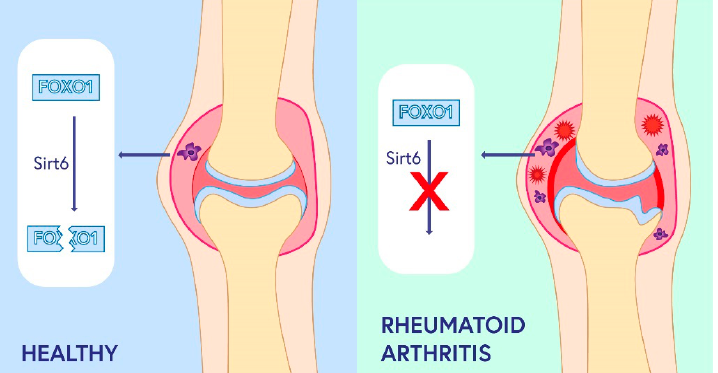
Figure 2. The role of sirtuin 6 in rheumatoid arthritis. In healthy joints, SIRT6 deacetylates FOXO1, leading to its transport into the cytoplasm and subsequent degradation. In RA patients, deacetylation of FOXO1 (Forkhead box protein O1) by SIRT6 in macrophages is impaired, resulting in the activation of immune cells, increased inflammation, and tissue destruction.